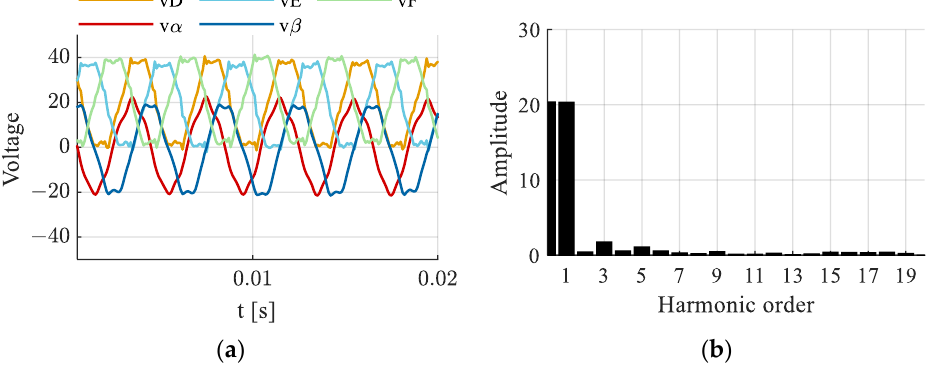
Figure 13. Measured voltages during the steady-state three-phase operation: ( a ) measured phase voltages and their transformed α–β components; ( b ) frequency spectrum of the measured voltage vF.